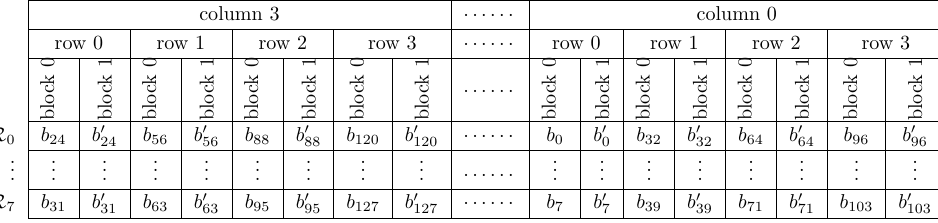
Figure 10: Bitsliced representation for Skinny-128 using 8 32-bit registers R 0 , · · · , R 7 to process 2 blocks b 0 , b 1 in parallel where b i 1 t = r & 0x03030303; 2 r = r ˆ ROR(t, 30); 3 t = r & 0x30303030; 4 r = r ˆ ROR(t, 4); 5 t = r & 0x03030303; 6 r = r ˆ ROR(t,